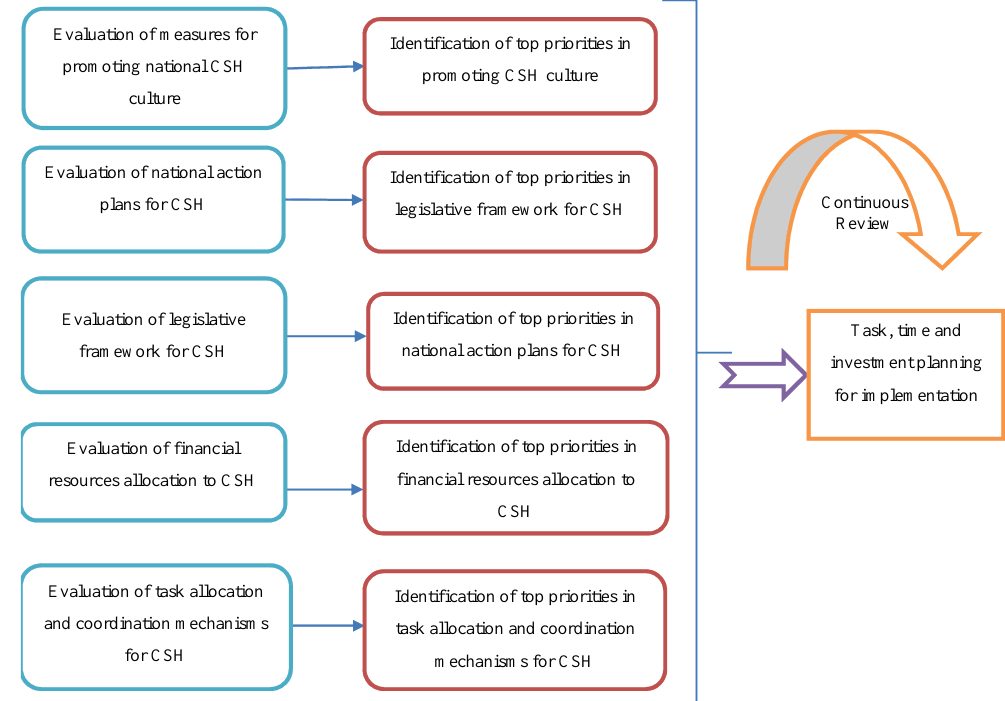
Fig. 1: National program for CSH (adapted from Bas,